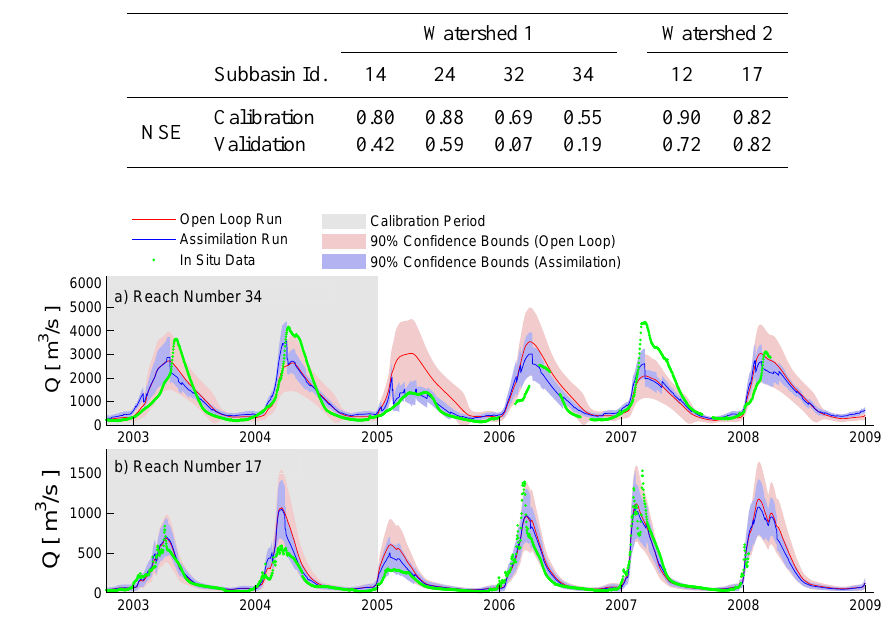
Table 3. NSE values for calibration and validation.